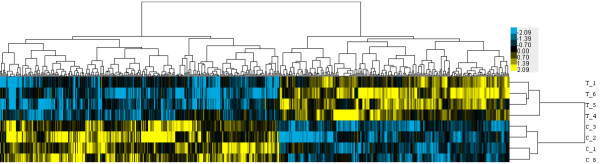
Gene expression differences between the control and 17β-trenbolone (TB) exposed female G. holbrooki as determined by hierarchical cluster analysis. Genes with fold changes > 1.5 fold or < −1.5 fold over controls and with one-way ANOVA p-values < 0.05 were used for this analysis, and 279 genes were found to be down-regulated by TB exposure and 229 genes up-regulated by TB exposure. Data were median-centered by gene and clustered using centered correlation and complete linkage. Yellow genes are more highly expressed than the gene average and blue genes are expressed at a lower level than the gene average. The resulting gene expression map demonstrates the distinct hepatic expression profiles of the vehicle control-exposed and TB exposed groups.